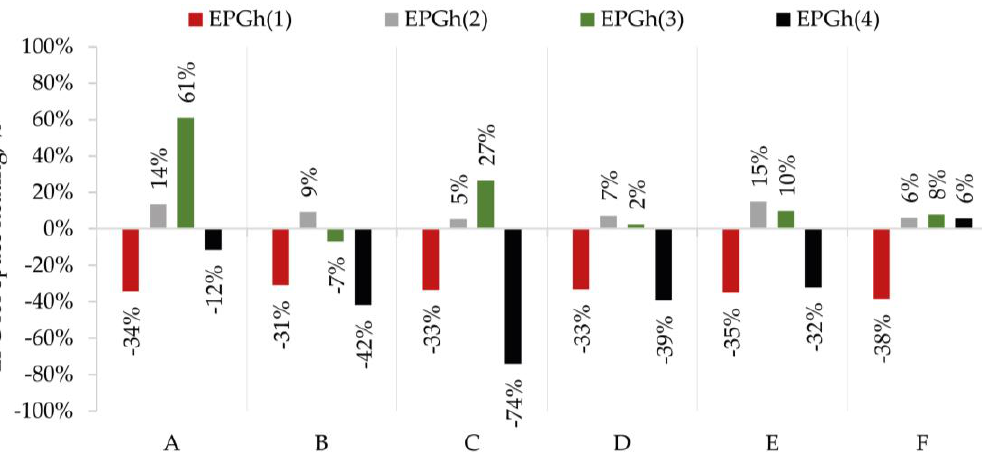
Figure 11. EPG for space heating for the analyzed parameters: EPG h (1) — outdoor air temperature, EPG h (2) — internal gains, EPG h (3) — influence of zones surrounding the premises, EPG h (4) — internal temperature and ventilation.